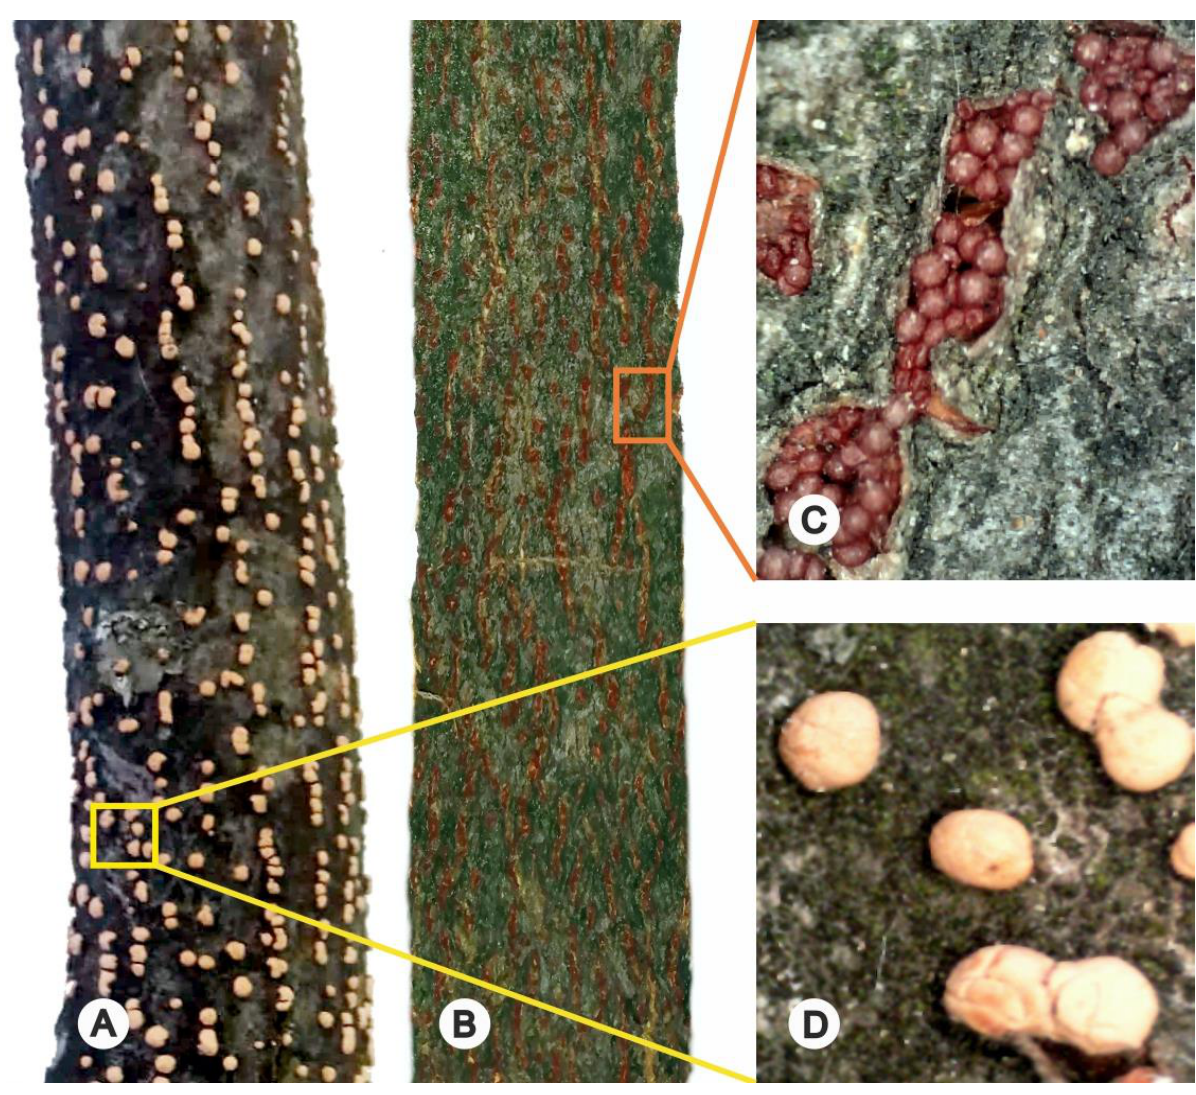
Figure 1. Sycamore maple branch attacked by Nectria cinnabarina fruiting bodies in the anamorph ( A ) and teleomorph ( B ) developmental stages, respectively. The closeup view of fruiting bodies in the anamorph ( D ) and teleomorph ( C ) stages, respectively.